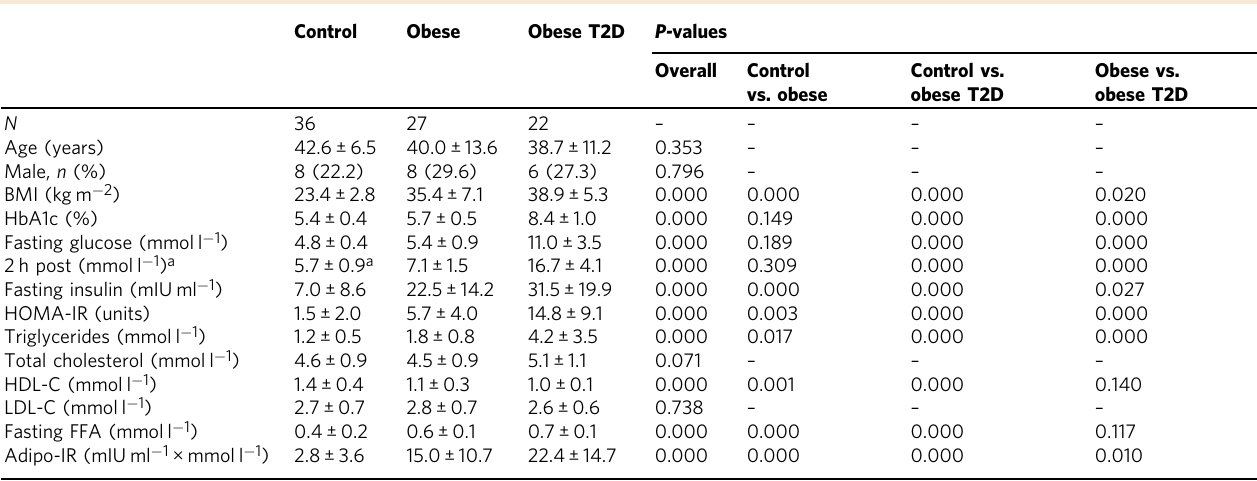
Table 1 Characteristics of subjects whose blood samples were analyzed Control